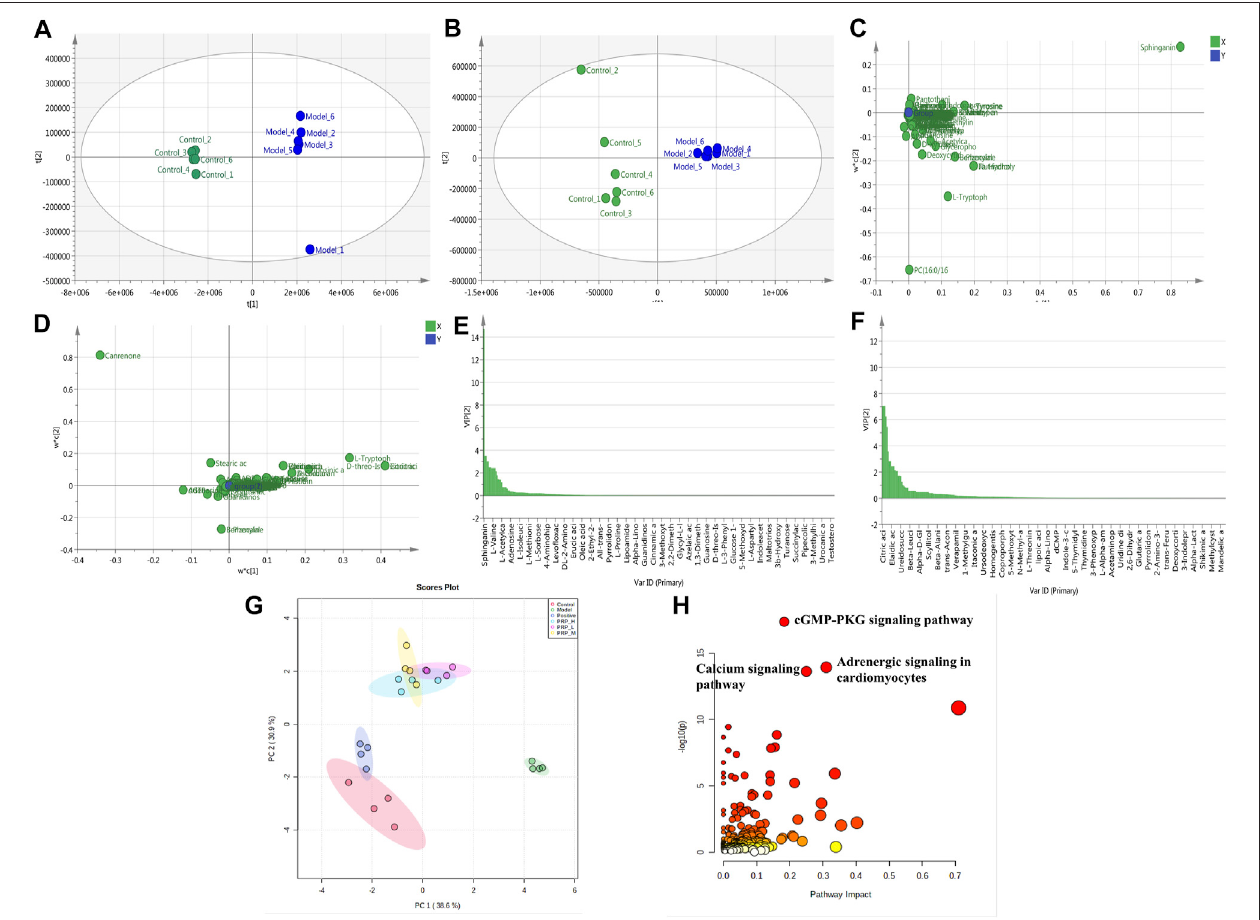
FIGURE 4| Effects of PRPon metabolite alterations induced by barium chloride in zebra fi sh embryos. R 2 Y (cid:2) 0.999, Q 2 (cid:2) 0.995 in positiveion mode; R 2 Y (cid:2) 0.986, Q 2 (cid:2) 0.984innegativeionmode; (A) 2Dscoresplotinpositiveionmode; (B) 2Dscoresplotinnegativeionmode; (C) Loading plotinpositiveionmode; (D) Loading plot in negative ion mode; (E) VIP diagram in positive ion mode; (F) VIP diagram in negative ion mode; (G) PCA scores plot of different metabolites in each group; (H) Metabolic pathway enrichment analysis diagram.